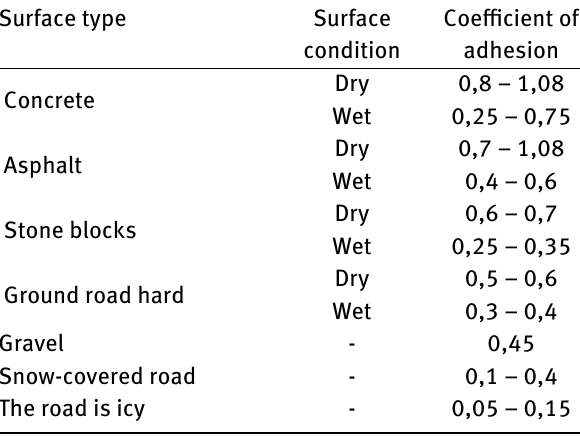
Table 4: Frequent ranges of the coeflcient of adhesion